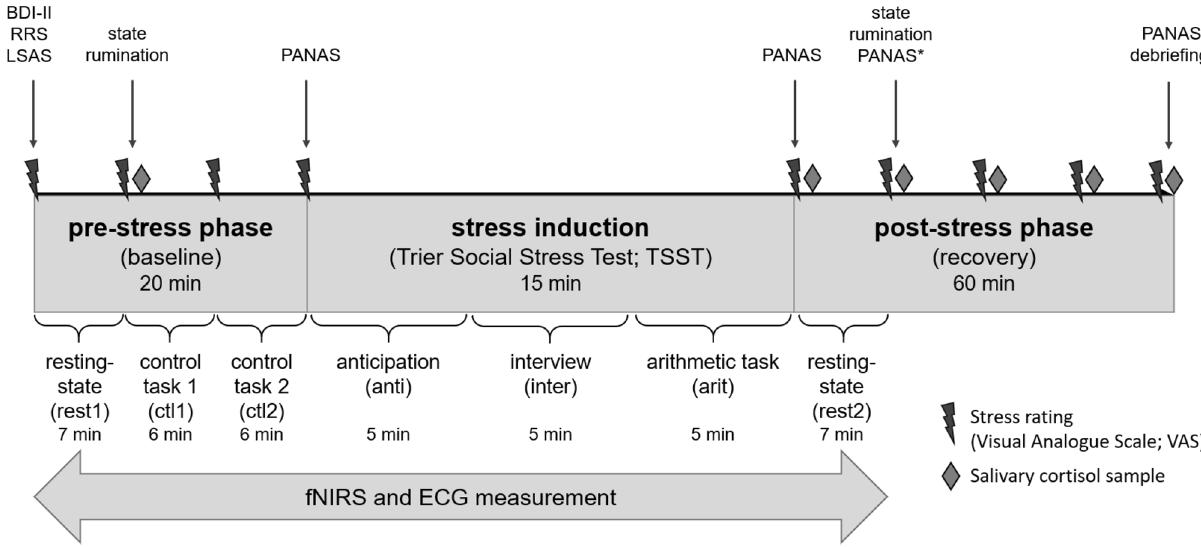
Figure 3. Time course of the TSST. BDI-II Beck Depression Inventory II 88 , RRS Rumination Response Scale 9 , LSAS Liebowitz Social Anxiety Scale 90 , PANAS Positive and Negative Affect Scale 97 . *The third PANAS was differently assessed in study 1 (post 15 min) and 2 (post 60